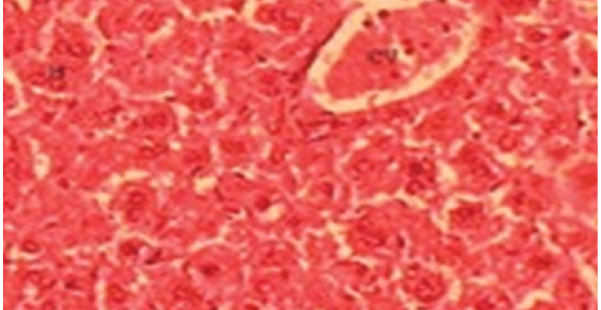
Fig. 4. Liver section obtained from a rat after treatment with lead acetate and vitamin c showing improvement of hepatic